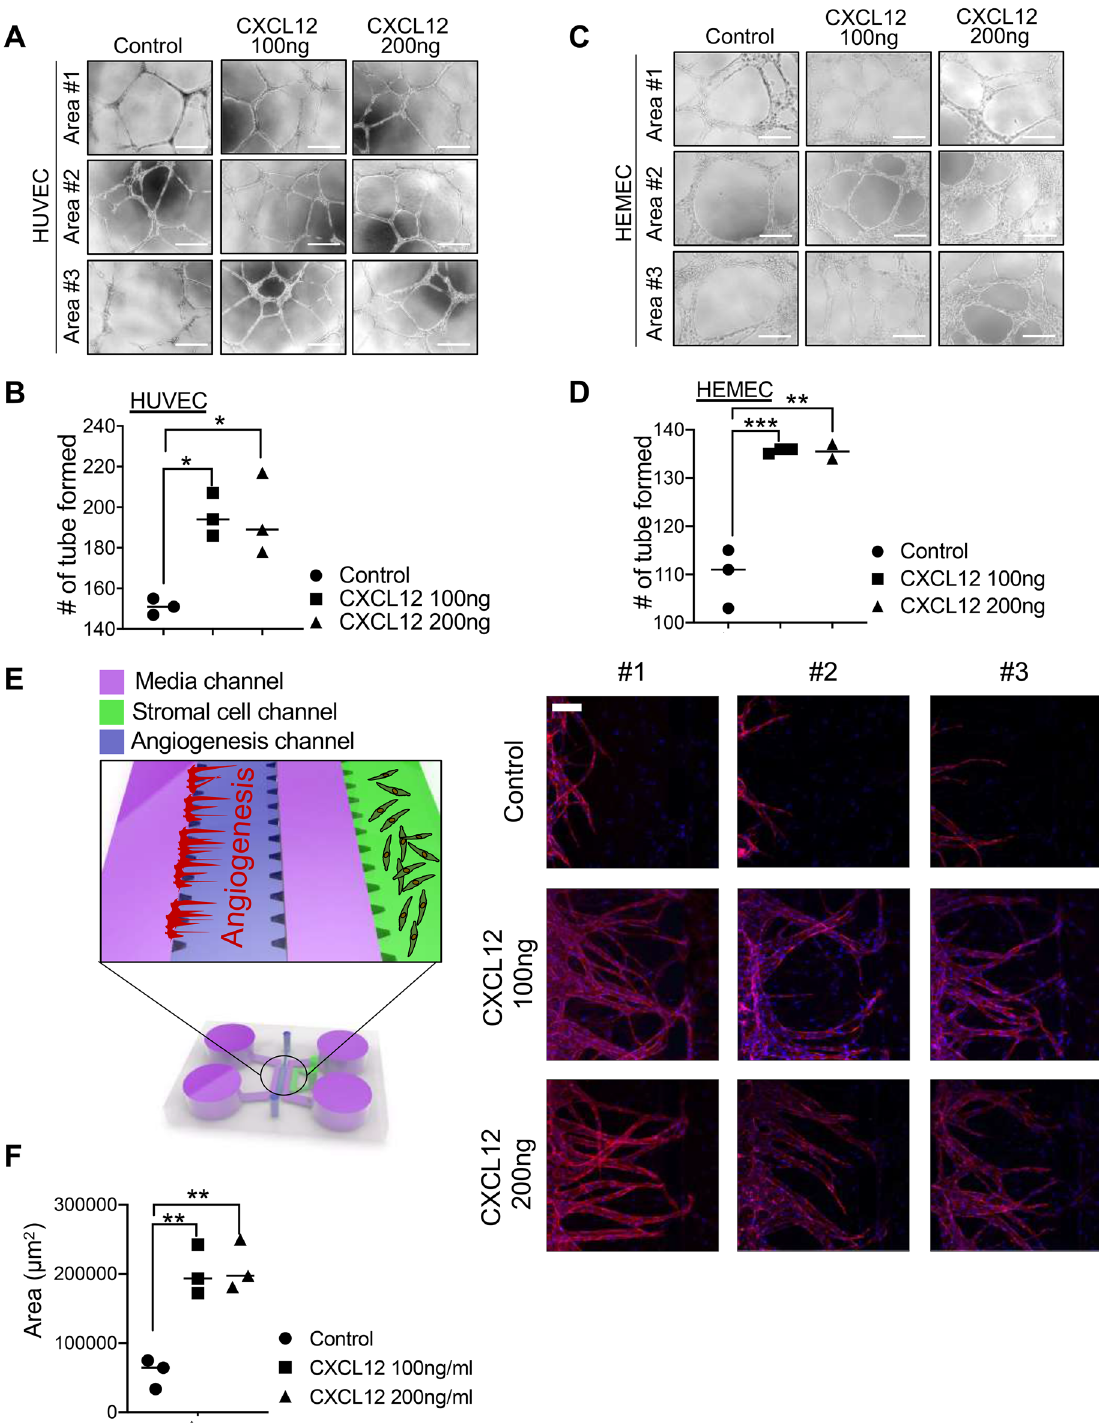
Figure 2. The role of CXCL12 treatment in vessel formation of vascular endothelial cells. Representative images showing tube formation of HUVEC ( A , B ) or HEMEC ( C , D ) in the absence or presence of CXCL12 (100 ng/ ml or 200 ng/ml) for 48 h. Scale Bar; 200 μm. The total number of tube loops was quantified in graphs shown in ( B ) and ( D ). Data are from 3 independent experiments, and analyzed using unpaired Student t test analysis including p values (*< 0.05, **< 0.01, ***< 0.001, NS; not significant). ( E ) A micro-engineered vascular system to detect the angiogenic effect of CXCL12. Representative confocal microscopic images of angiogenic sprouting of HUVECs in response to CXCL12. Scale bar: 100 μm. The total surface area of HUVEC sprouting was quantified in a graph shown in ( F ). Data shown in ( F ) are from 3 independent experiments and analyzed using the ordinary one-way ANOVA analysis with Dunnett’s multiple comparison test including P values (*< 0.05, **< 0.01, ***< 0.001, ****< 0.0001, NS; not